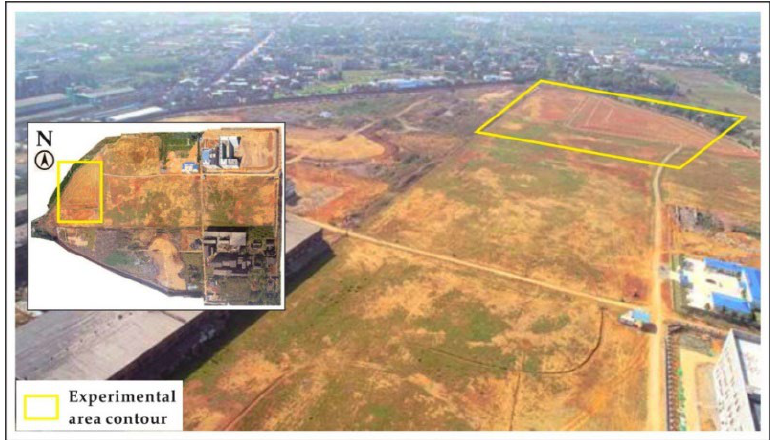
Figure 1. Location map of the study area.